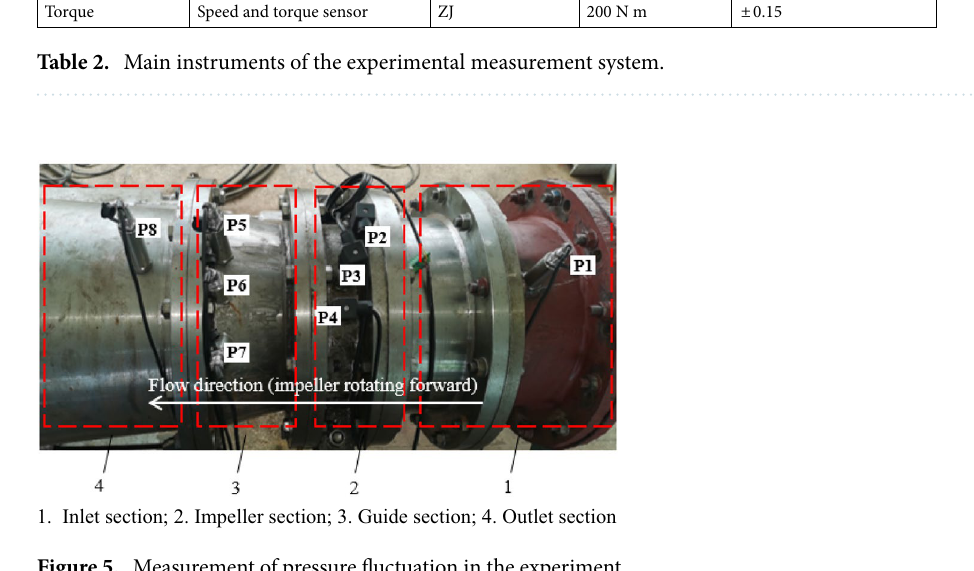
Figure 5. Measurement of pressure fluctuation in the